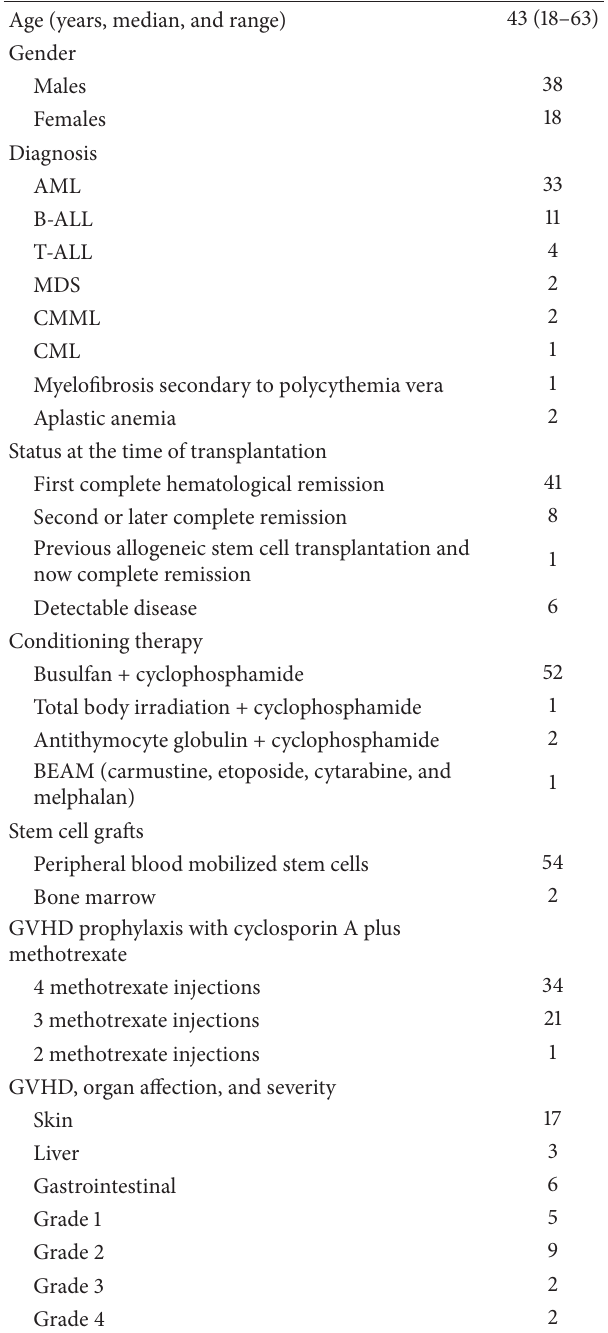
Table 1: Clinical and biological characteristics of allotransplanted patients included in the